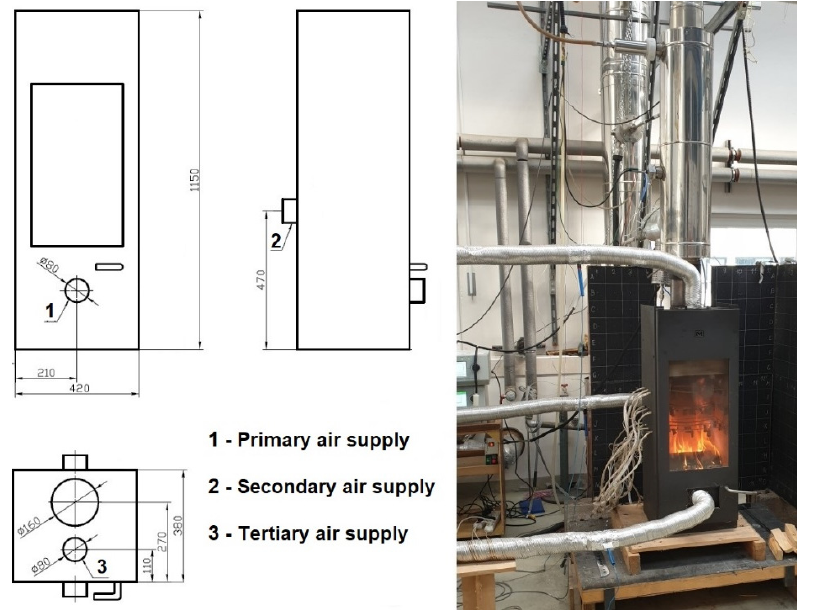
Figure 2. The distribution of the individual air supplies.